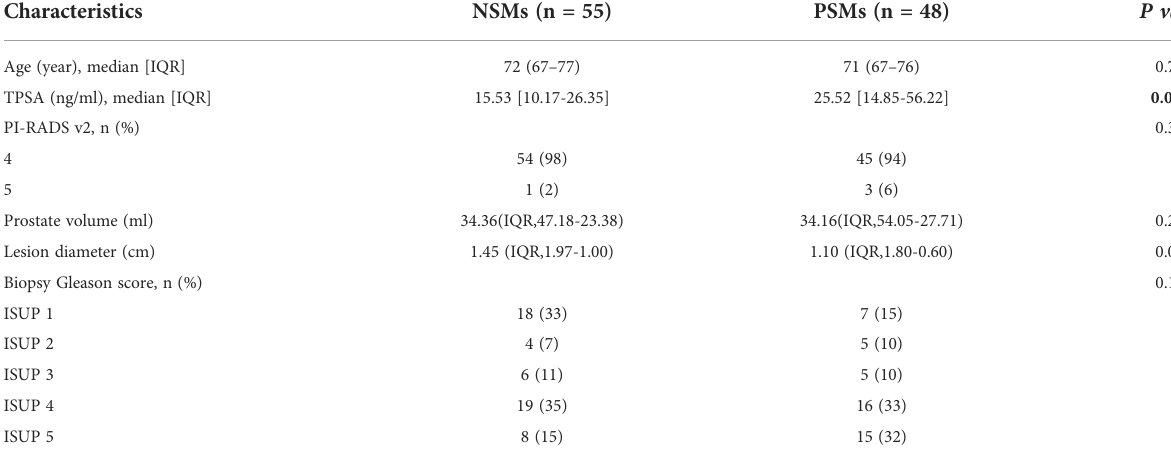
TABLE 2 Clinical characteristics of patients with negative and positive